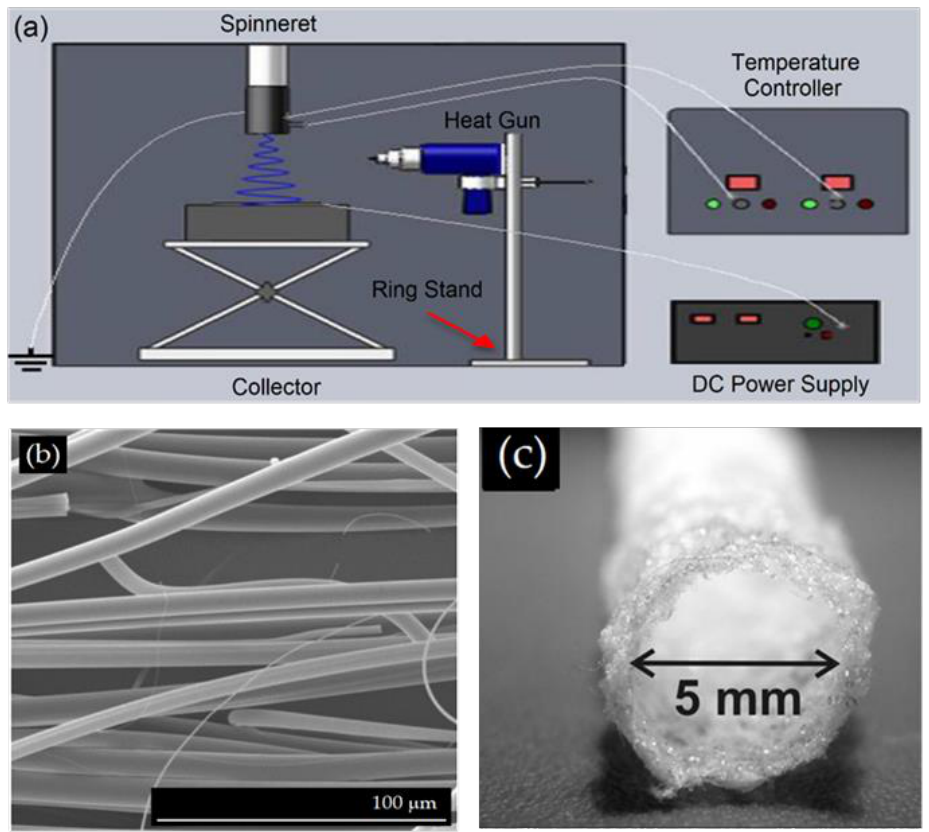
Figure 9. ( a ) A schematic illustration of the melt electrospinning apparatus, reproduced with permis- sion from [57] (License number: 5236501189506), ( b ) Morphology of PLA melt-electrospun